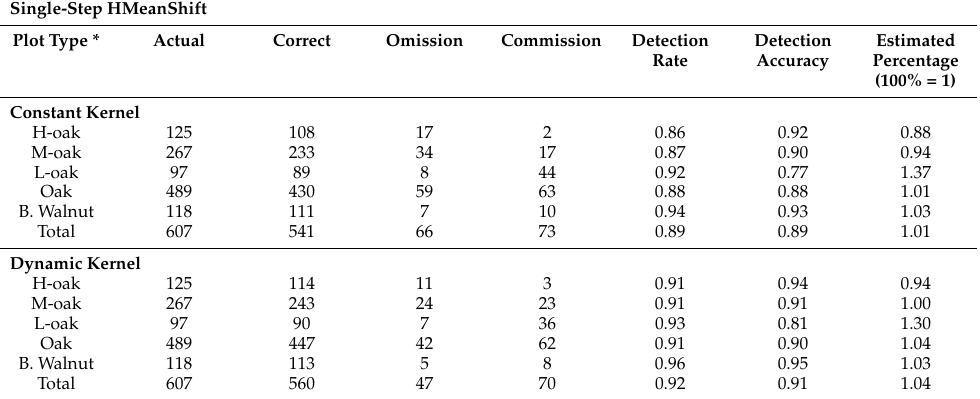
Table 2. The results of individual tree detection using single-step HMeanShfit with either a constant or dynamic